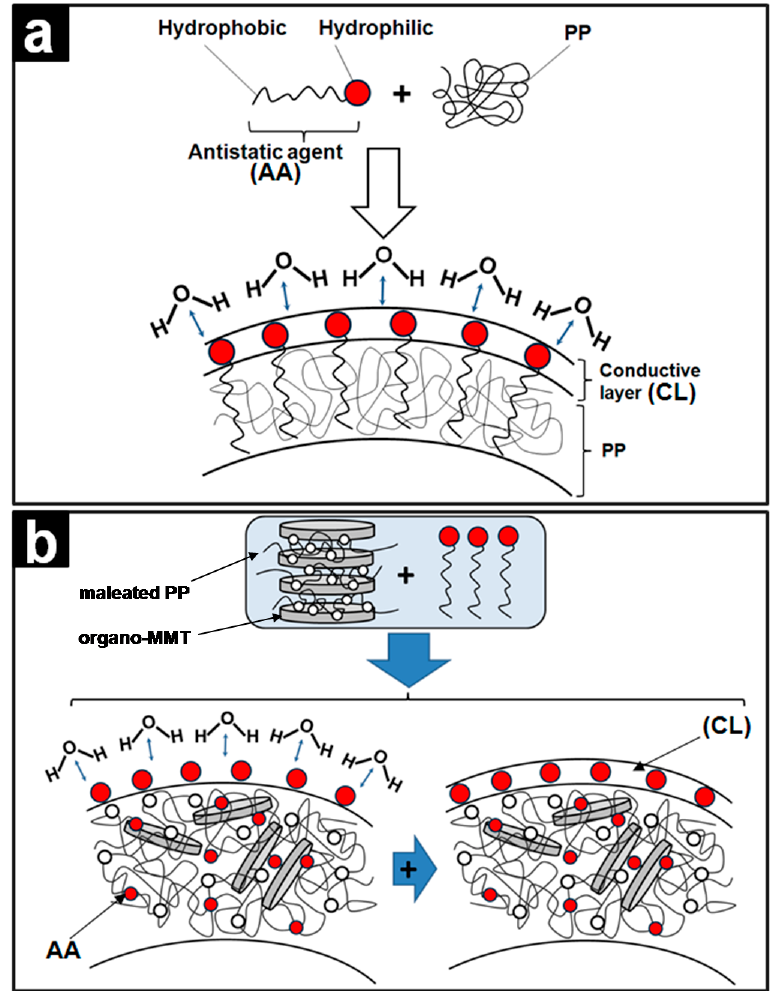
Figure 15. Schematic depicting possible interaction mechanisms between either PP and AA (a), or between PP, AA and organo-MMT